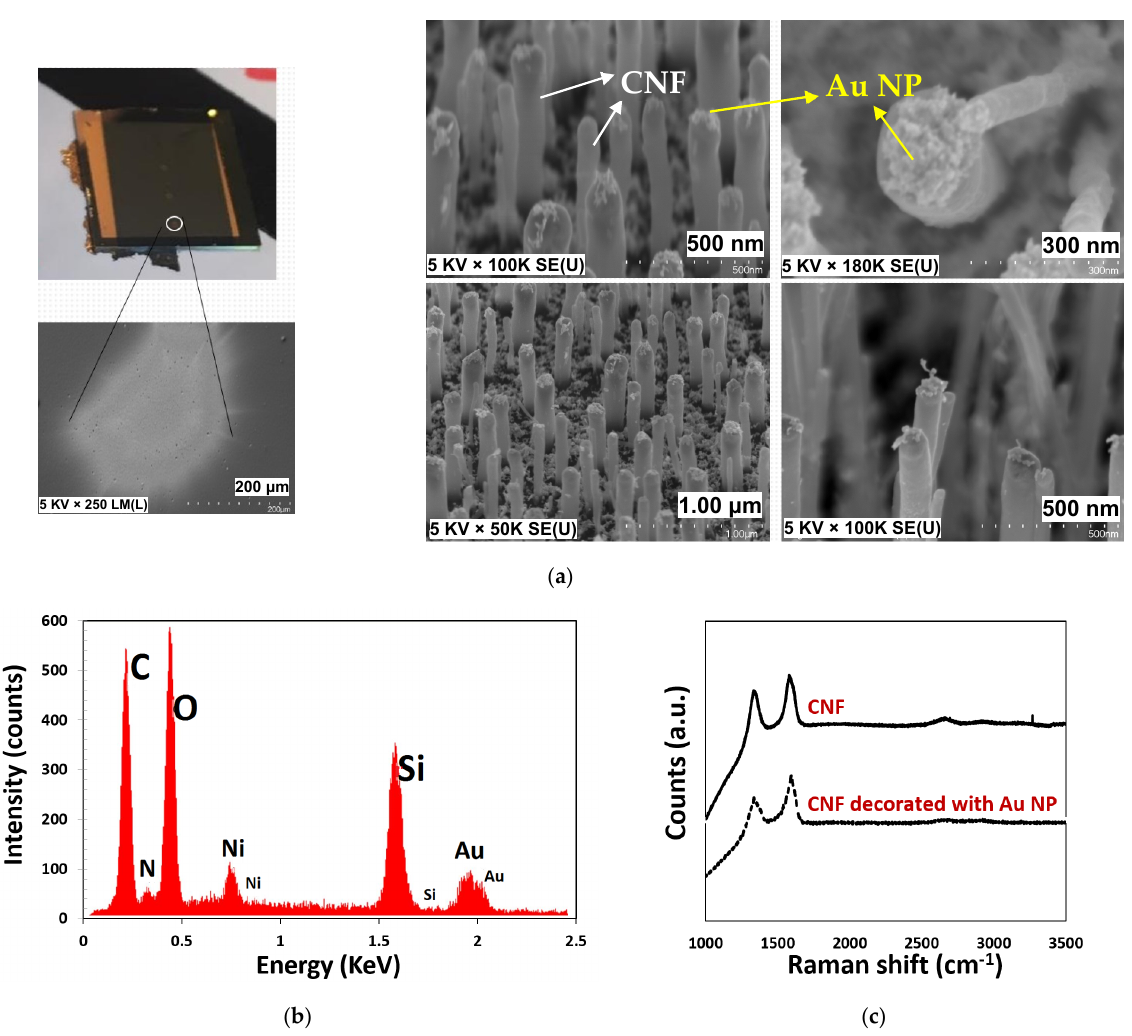
Figure 5. ( a ) Fabricated CNF sensor decorated with gold nanoparticles and zoomed-in view of printed nanoparticle point (left). SEM images of the CNF synthesized decorated with gold nanoparticles (right). ( b ) EDX spectrum of CNF with gold nanostructures. ( c ) Raman spectra of CNF and CNF decorated with gold nanostructures.